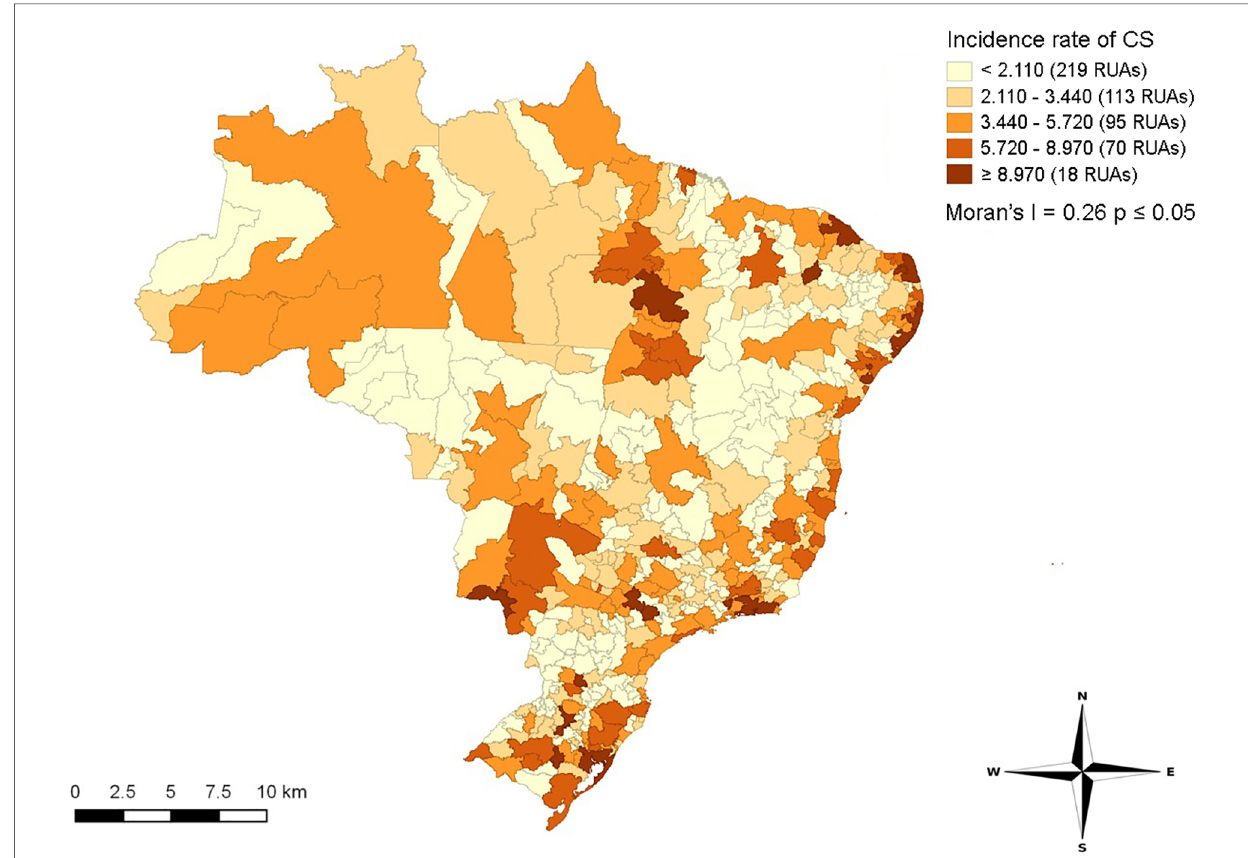
FIGURE 2 Spatial distribution of clusters (exploratory map) of the incidence rate of congenital syphilis, in immediate regions of urban articulation in Brazil, 2008 –